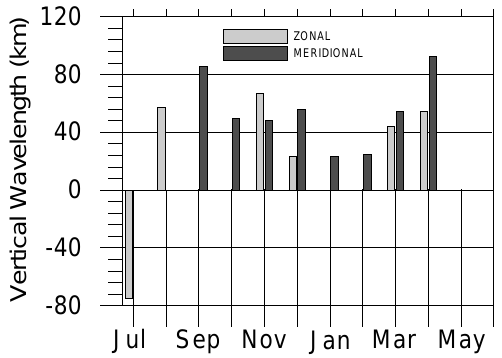
Fig. 11. Vertical wavelength of semidiurnal oscillation for zonal and meridional components from July 2004 to June 2005.